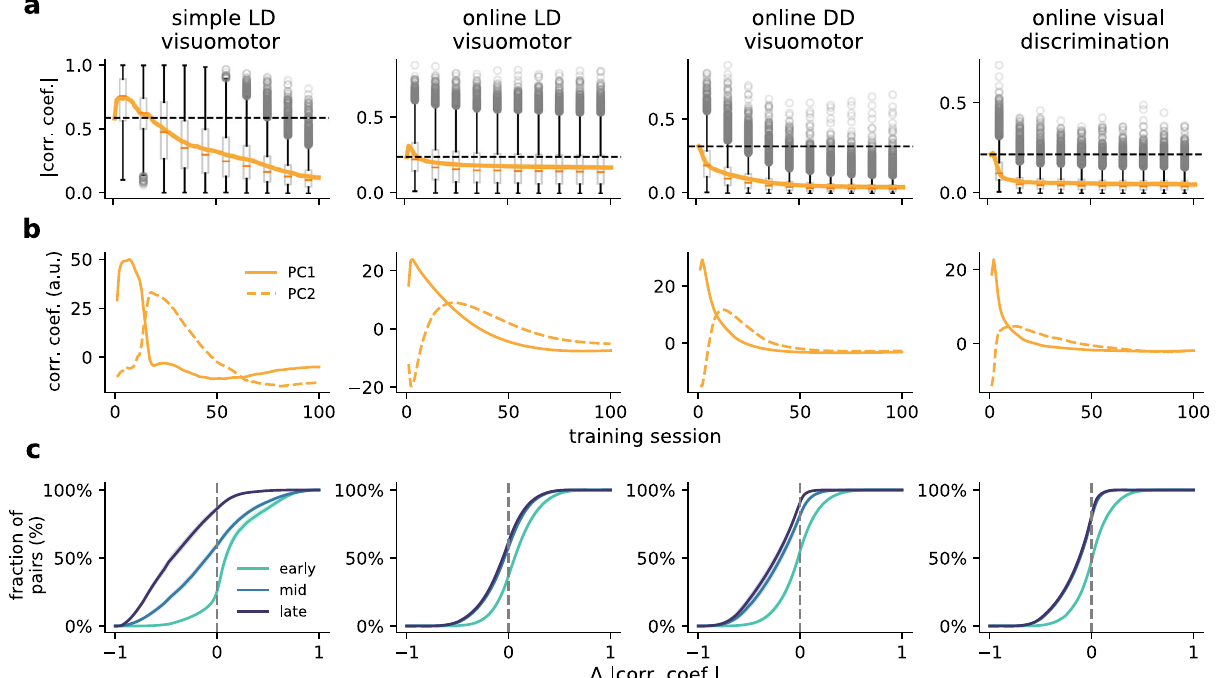
fi rst two principal components of cerebro-cerebellar pair-wise correlation coef fi - cients over learning (all components available in Fig. S14). c Cumulative plot of cerebro-cerebellarpairswithpositiveand negativechangesinabsolutecorrelation coef fi cientsinearly(session1),mid(session25)andlate(session80)learning.Data groupedacross 10 different initialconditions,where for each condition wesample 600 active pairs for the simple LD visuomotor task and 1000 active pairs for the online tasks (see the “ Methods ” section). Source data are provided as a Source Data fi